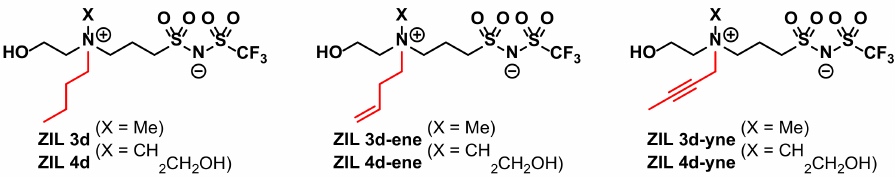
Figure 6. Structures of sidechain-engineered zwitter-ionic liquids: ZIL 3d-ene , ZIL 3d-yne , ZIL 4d-ene , and ZIL 4d-yne